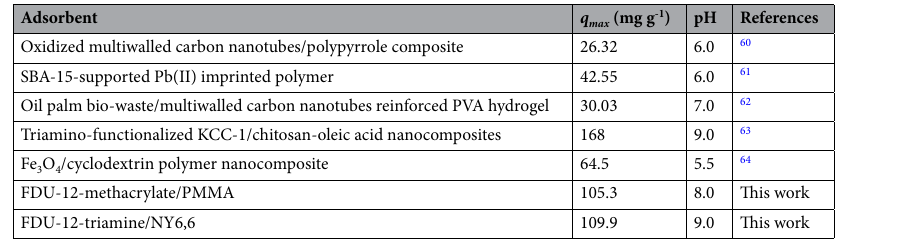
Table 3. Comparison of the adsorption capacity of the prepared adsorbents toward Pb(II) ions with other adsorbents.